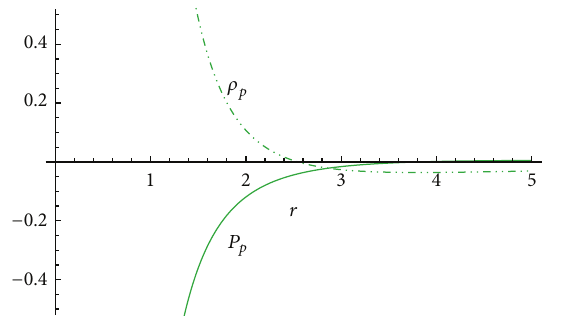
Figure 1: Energy density and pressure for the BH with phantom global monopole along 𝑟 for 𝜂 = 0.15 and 𝑀 = 1 .